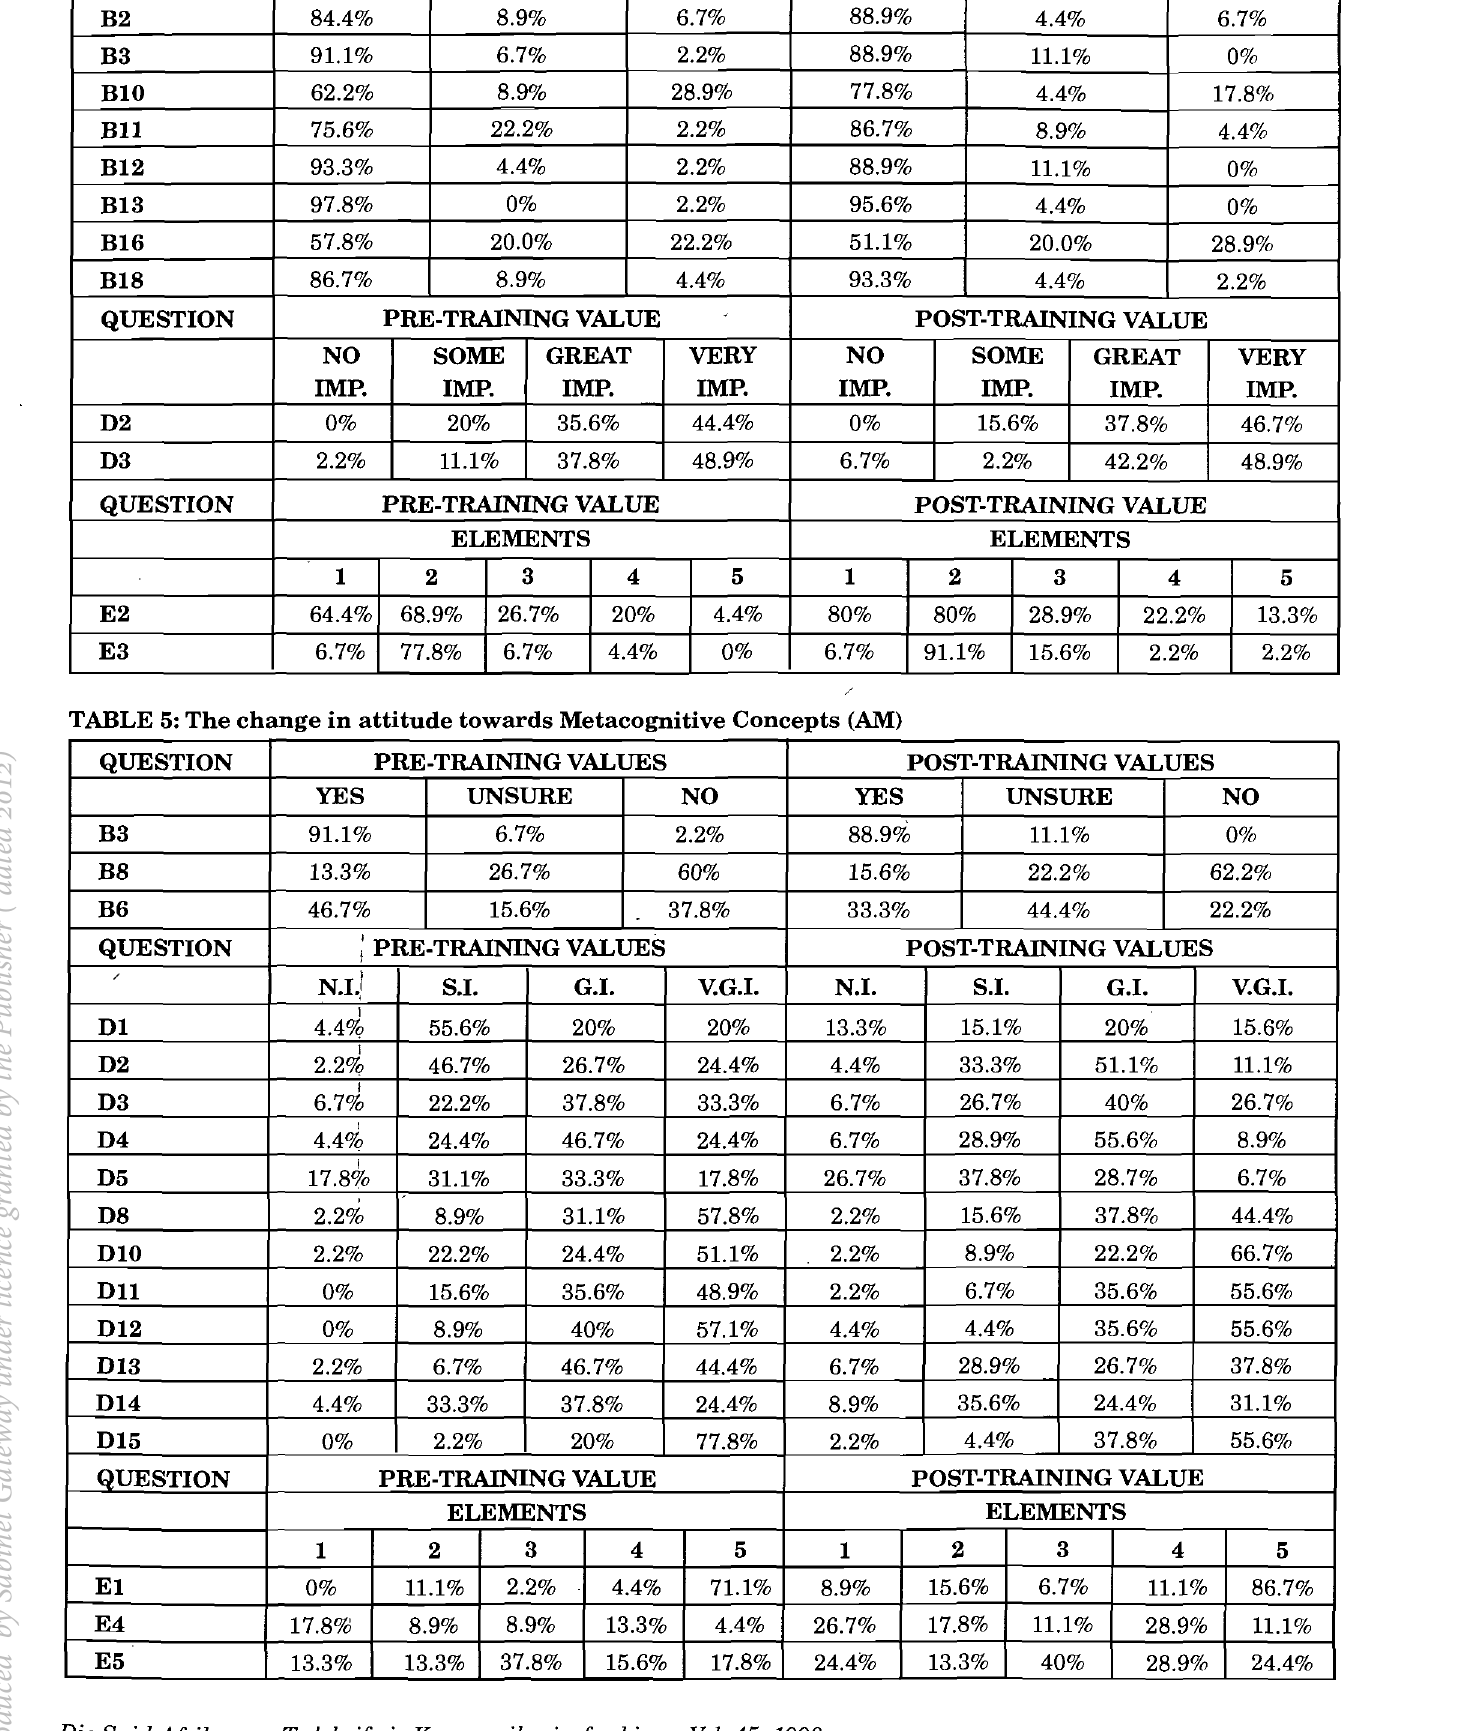
TABLE 4: The change in attitude towards Neuropsychological Concepts (AN) QUESTION